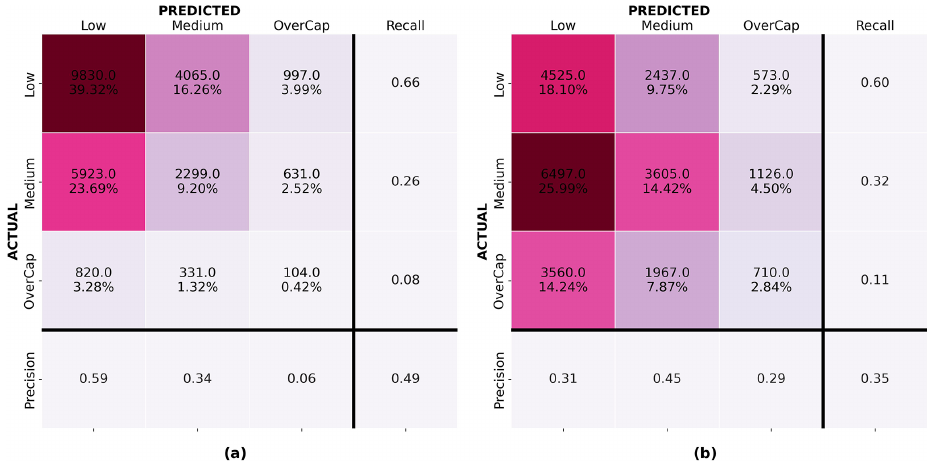
Figure 15. Confusion matrices for the predictions from the RiskScape v1.0.3 software on a sample of 25000 buildings located in Christchurch, New Zealand: (a) predictions for the 4 September 2010 earthquake and (b) predictions for the 22 February 2011